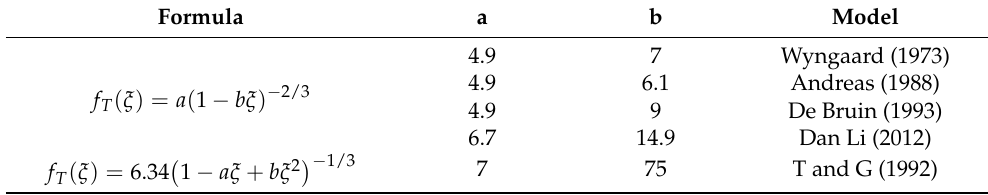
Table 1. Expressions for similarity functions under unstable conditions ( ξ < 0 ).